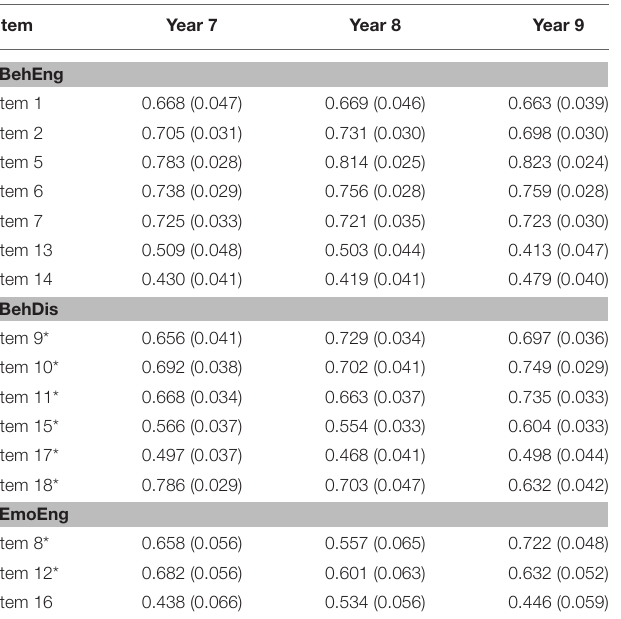
TABLE 4 | Standardized factor pattern/structure coefficients (and standard errors) for the CFA model across 3 years.